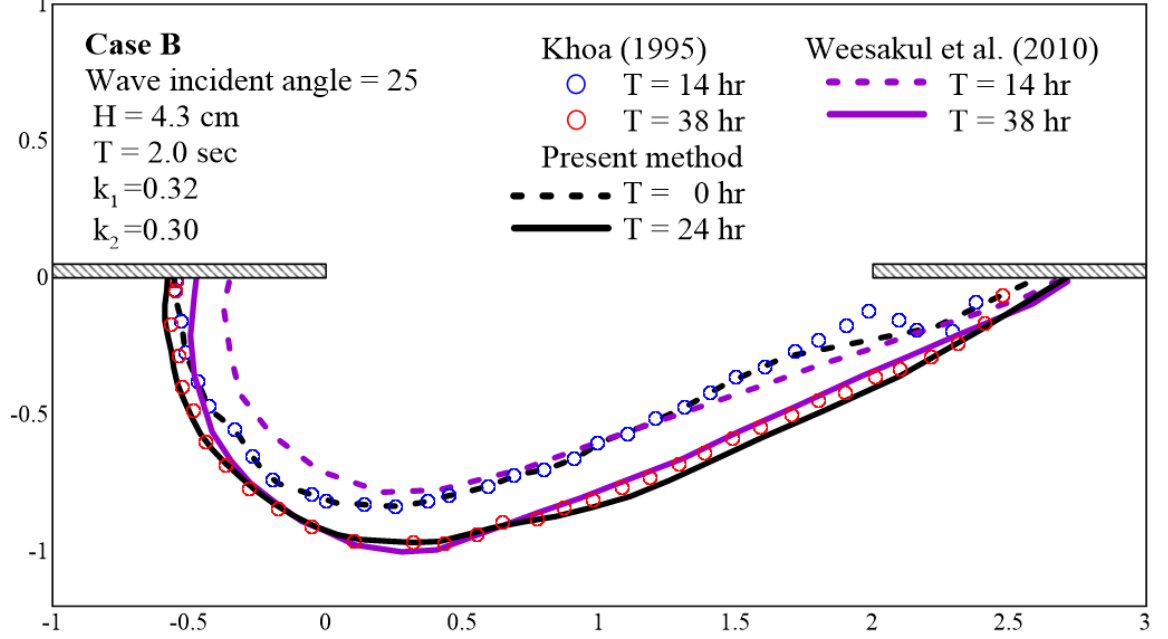
Figure 8. Numerical comparisons of the present model and previous study [20,28].